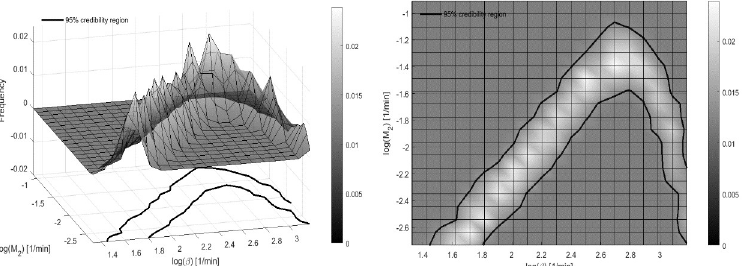
Fig 8. MCMC a-posteriori distribution. Empirical a-posteriori bivariate distribution for parameter (log( β ), log( M 2 )), along with the 95% Credibility Region (CR).